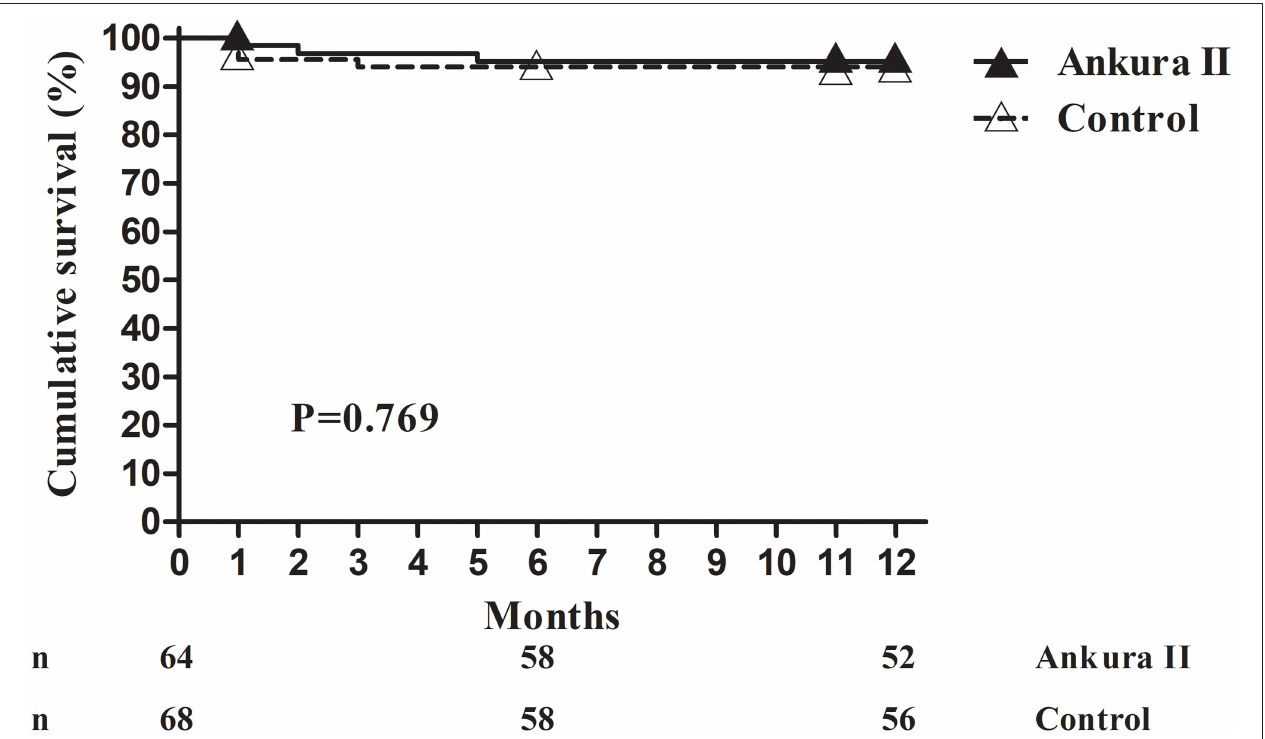
FIGURE 3 | Kaplan-Meier survival analysis. The available number of patients between the Ankura II and Ankura groups was 64 and 68 at 0 months, 58 and 58 at 6 months, and 52 and 56 at 12 months,